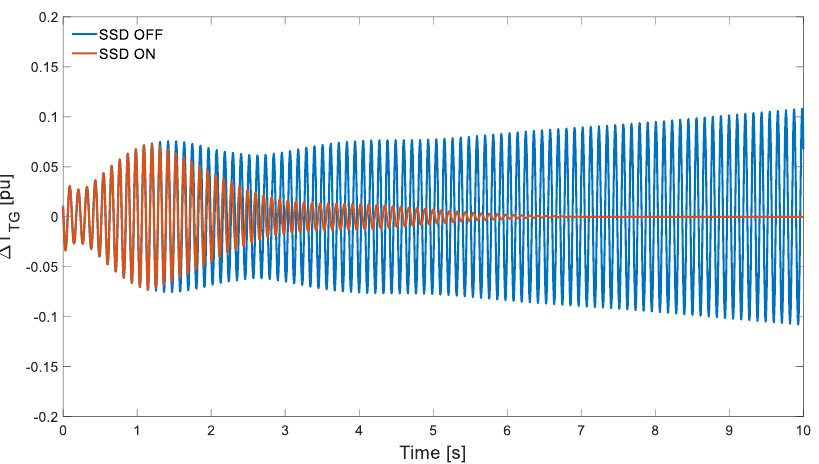
Figure 12. Torque oscillation Δ T TG at the first TNF in configuration CB (results related to the data of Table 4).